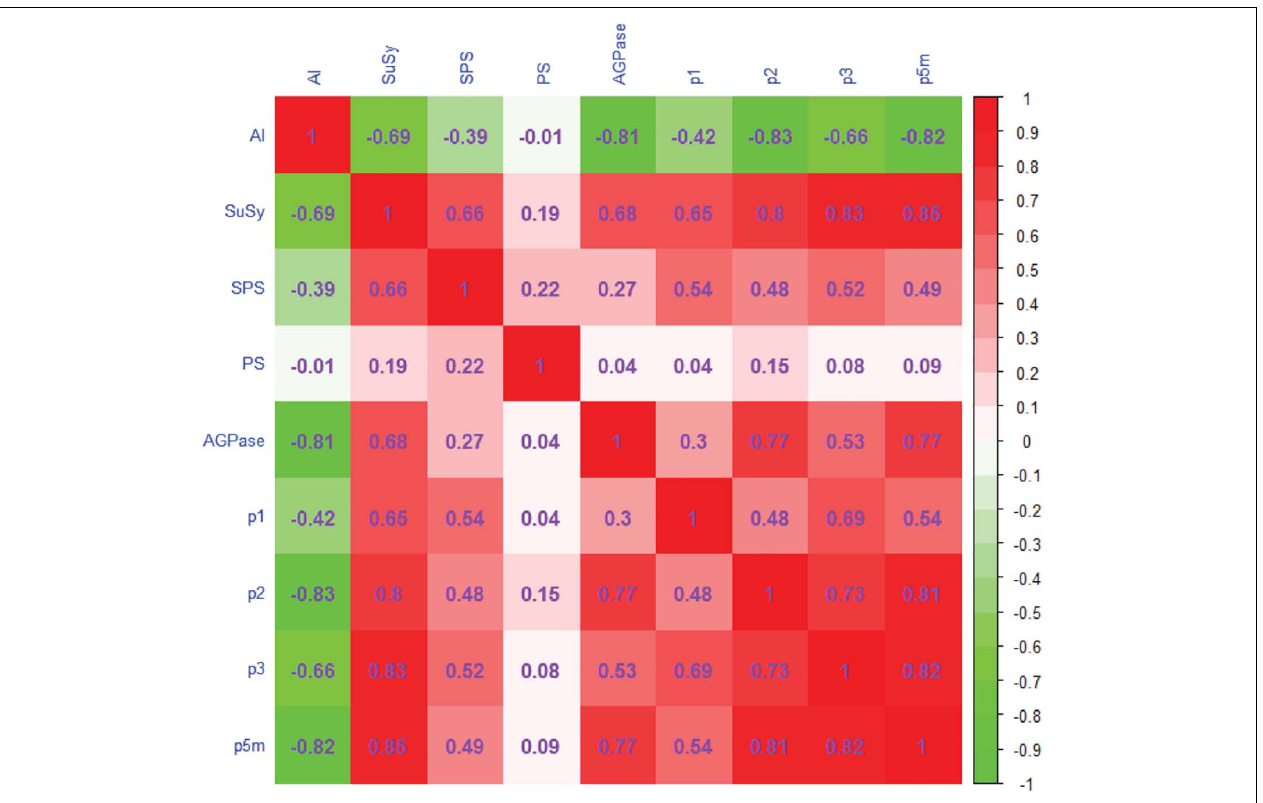
FIGURE 7 | Correlation matrix relating enzyme activity and the rate of carbon conversion in tomatoes. The cell containing the Spearman correlation coefficient (positive or negative) is colored according to the color key (red positive, green negative, white zero). Color intensity increases as the absolute value of the correlation